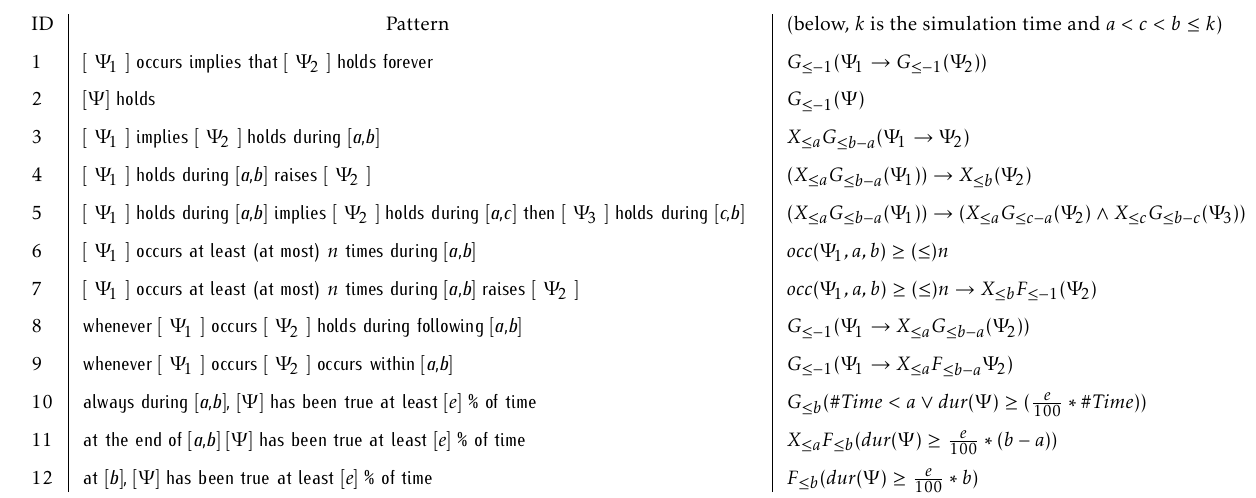
∈ OCL-prop , a, b ∈ R , e ∈ OCL-expr Ψ 1 , 2